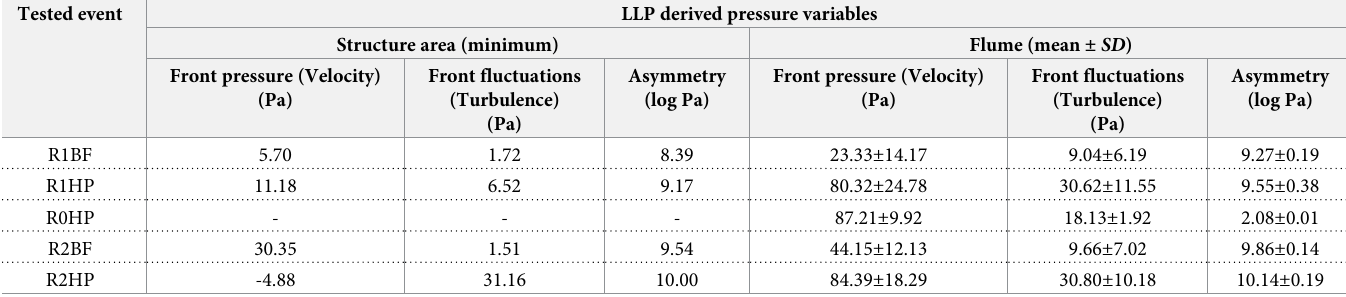
Table 3. Minimum (Pa) and mean ± SD (Pa) LLP derived pressure variables. The minimum pressure values (Pa) for mean front pressure ( � p fluctuations ( � p 0 ) and mean pressure asymmetry ( D � p ) refer to the results observed in the three rectangles measured behind the structure, Mean ± SD (Pa) refer to the 1 (cid:0) 6 12 pressure values observed in the flume (excluding structure area) for events R1BF, R1HP, R0HP, R2BF and